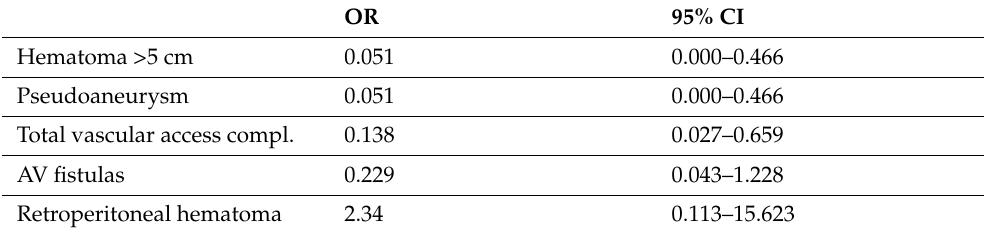
Table 7. Subgroup analysis of risk reduction using US in patients with BMI > 30 kg/m 2 . OR 95%